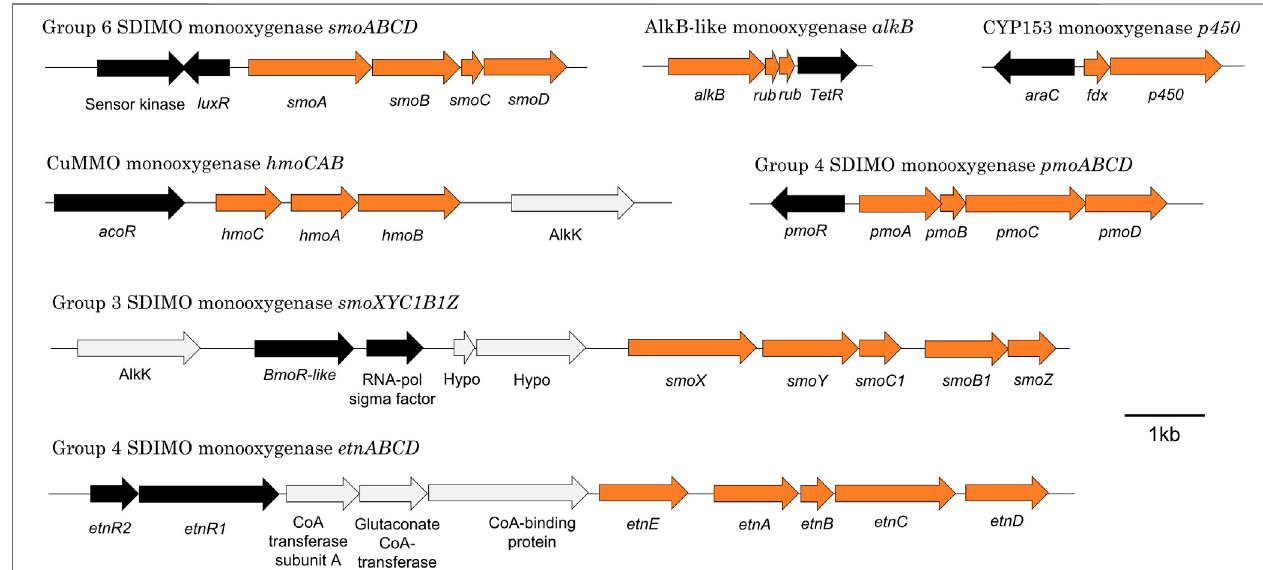
FIGURE 4 | Organisation of seven representative monooxygenase gene clusters from M. chubuense NBB4. Orange arrows represent monooxygenase subunits, black arrows represent putative regulator genes, and light grey arrows show other genes in the region.